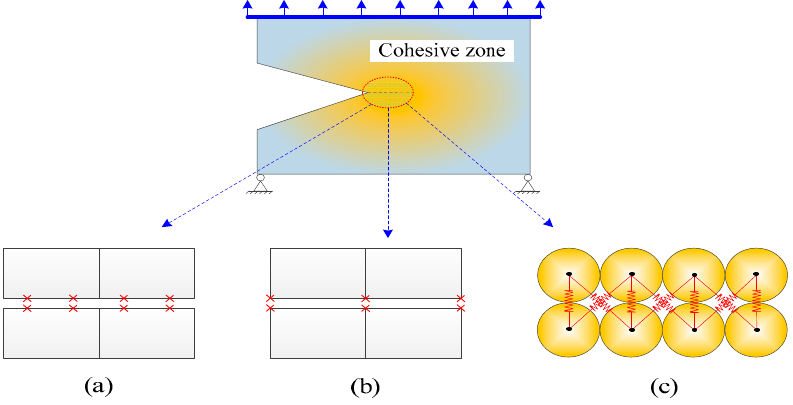
Figure 3. Schematic of different cohesive zone models in two dimensions: ( a ) continuum cohesive zone model with interaction through quadrature points; ( b ) discrete cohesive zone model with interaction through nodes; ( c ) particle-based cohesive zone model with interaction through DE particles.